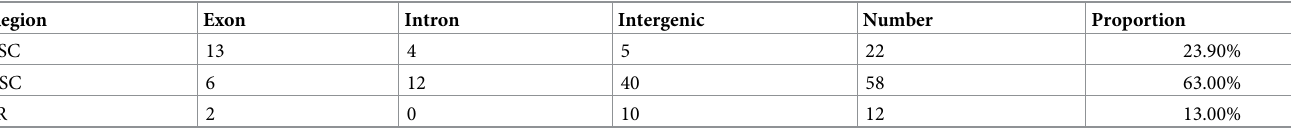
Table 8. Number of SSRs distributed in the SSC, LSC, and IR regions.